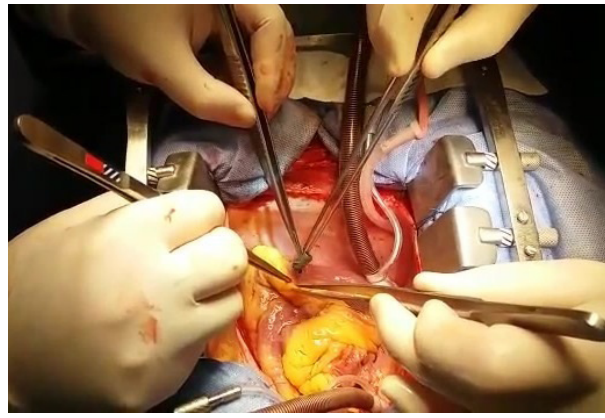
Fig. 2 - Removal of the projectile from the right